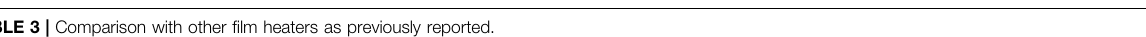
after 15 s, the generated temperature remained unchanged. This result indicates that FTFHs have a quick thermal response time, and CNTs are an excellent electrothermal material for FTFHs. On